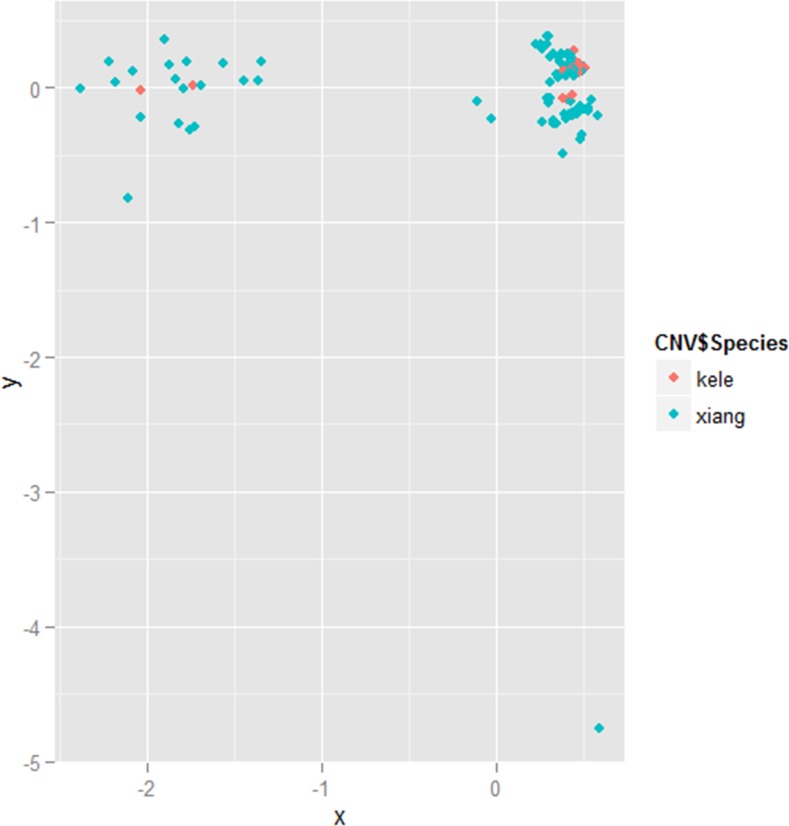
Hierarchical clustering analysis based on all available CNVR information.Individuals were plotted according to their coordinates on the biplot of x versus y. Blue: Xiang breed, Red: Kele breed.